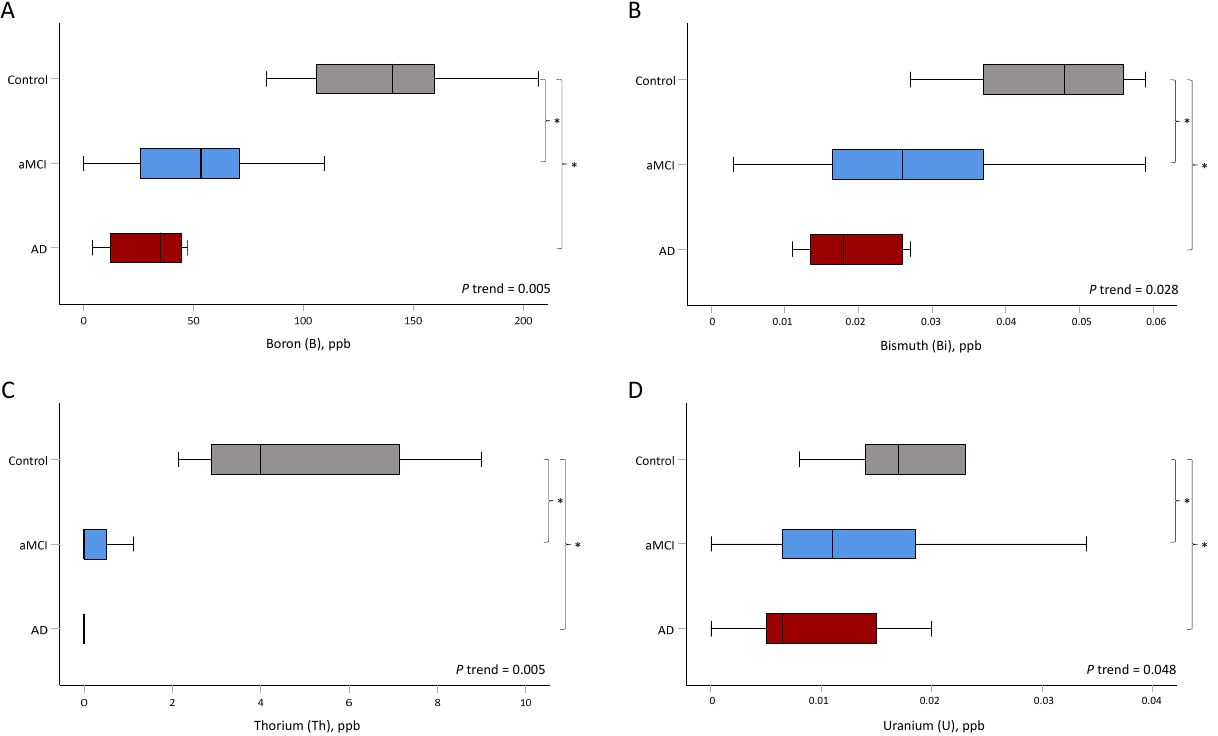
Figure 2. The distribution of trace metals was significantly different between aMCI and control groups and between AD and control groups. Asterisks (*) indicate statistical significance ( p < 0.05). ( A ) Boron, ( B ) bismuth, ( C ) thorium, and ( D ) uranium. aMCI, amnestic mild cognitive impairment; AD, Alzheimer’s